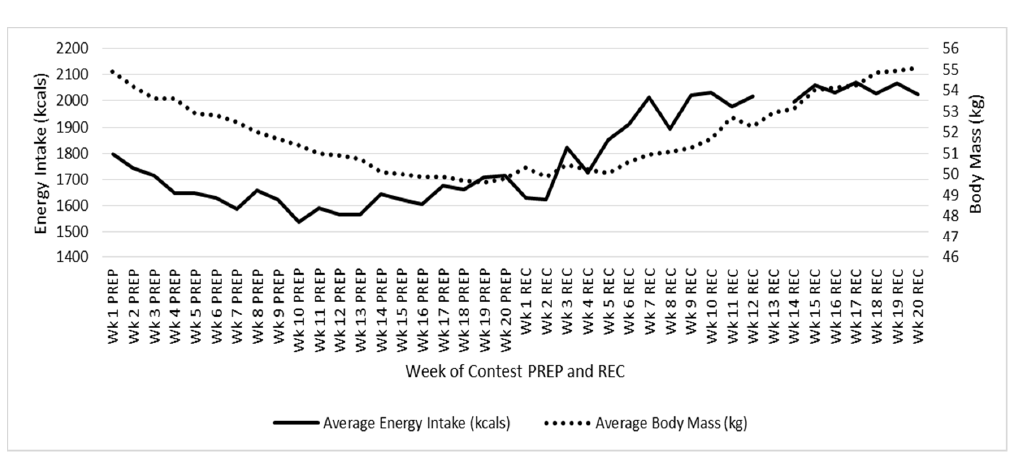
Figure 2. Changes in Energy Intake and Body Mass during Competition Preparation and Recovery.